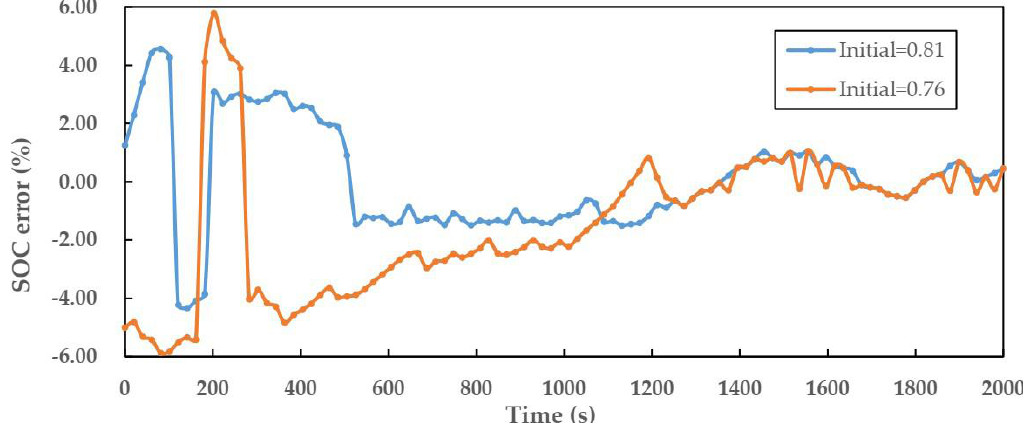
Figure 5. The estimated value of the Kalman filter method when the initial SOC values are different.